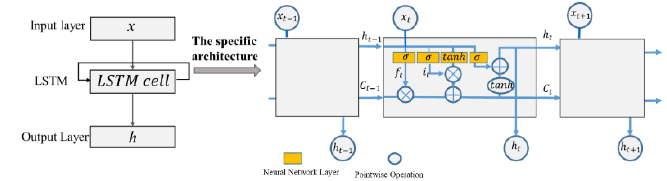
Fig. 4. Basic LSTM